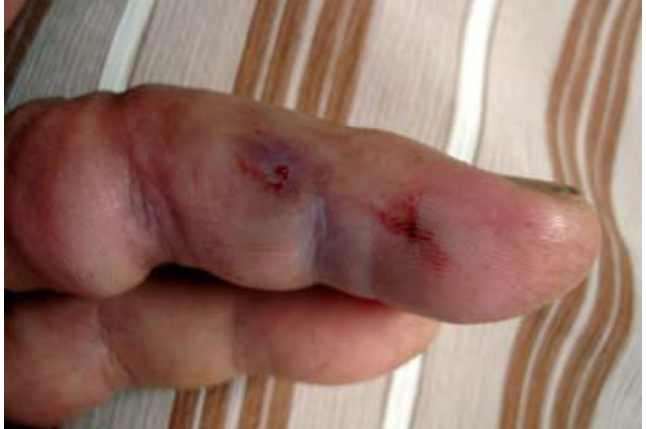
Figure 7. Two lesions on the left ring finger. Swelling and tissue necrosis are visible around fang marks (1.0 x 0.8 cm and 0.6 x 0.5 cm).